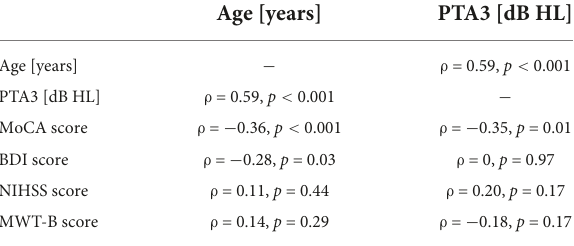
TABLE 2 Correlations between age and PTA3 thresholds and the results of the non-auditory measurements (MoCA, BDI, NIHSS, and MWT-B) for stroke and control group